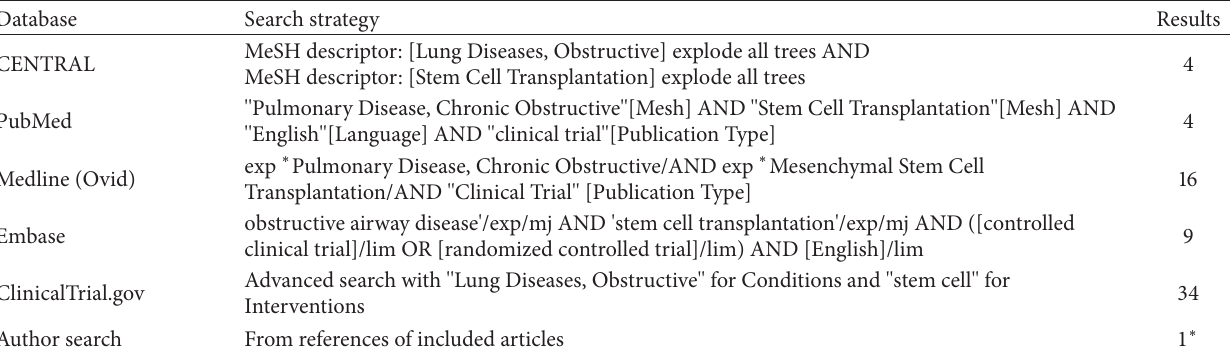
Table 1: Search strategies used in each